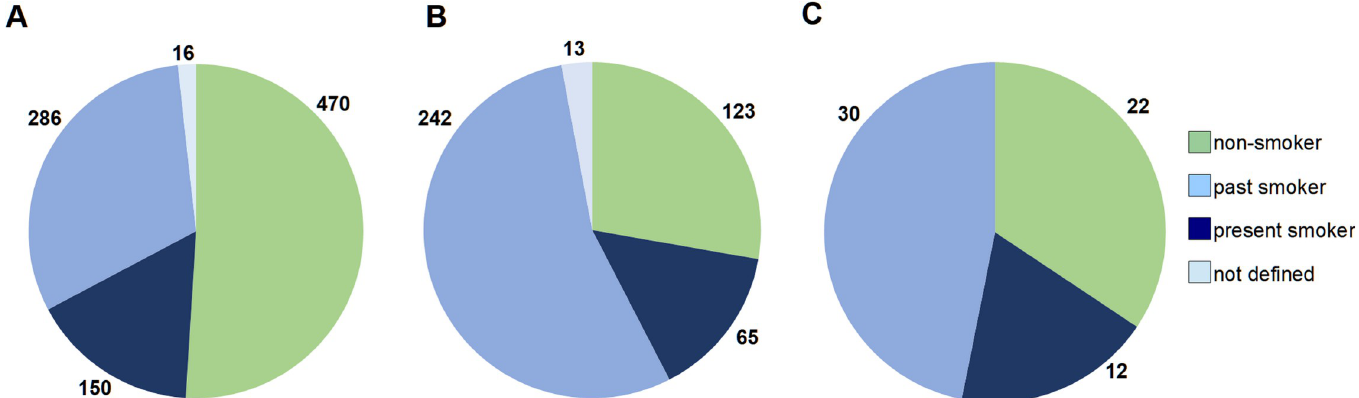
Fig 5. Smoking status declared by donors in the questionnaire. (A) Female cohort. (B) Male cohort. (C) Control male group, as described in Materials and